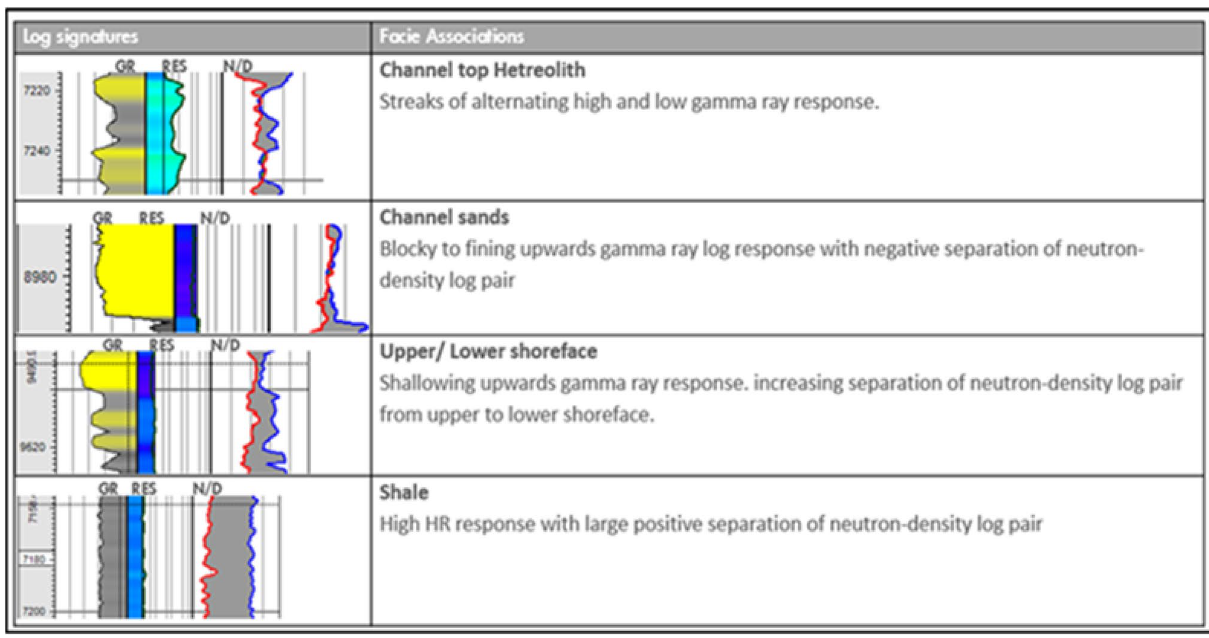
Fig. 7 Facies types identified from log motifs analysis, patterns and trends within the Koca